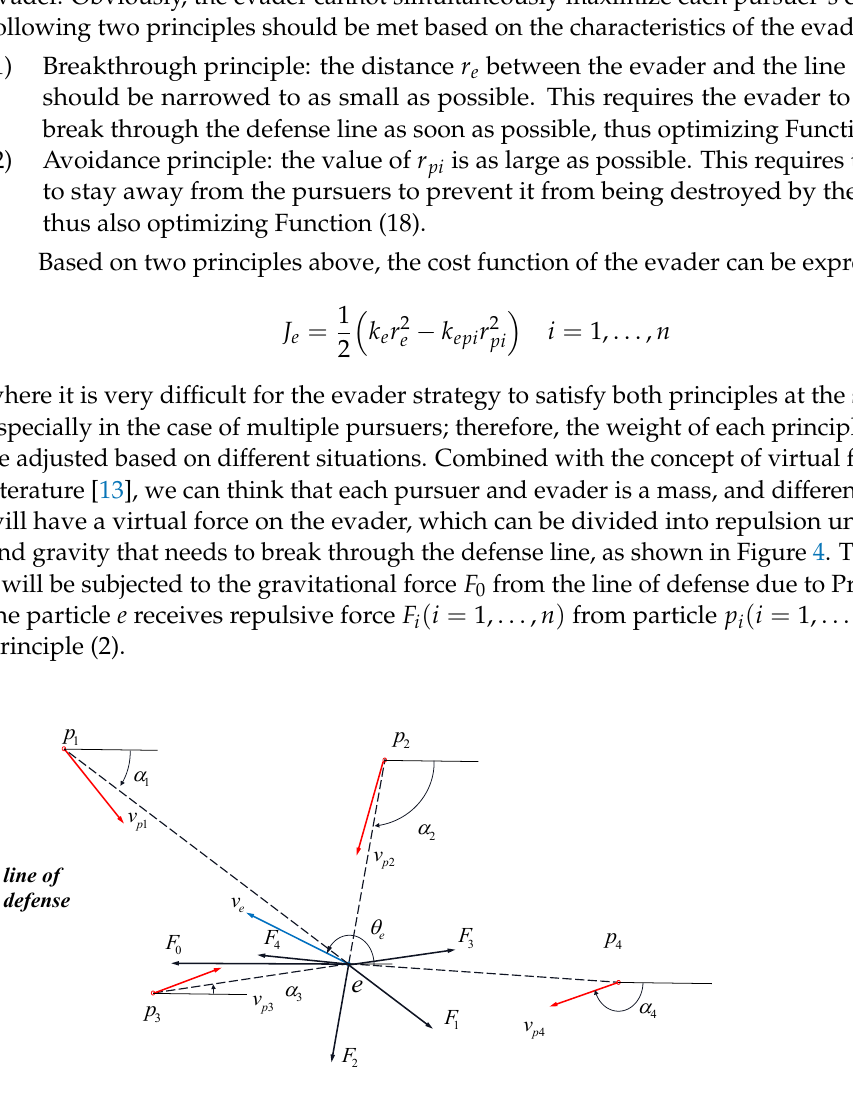
Figure 4. Virtual-force analysis of